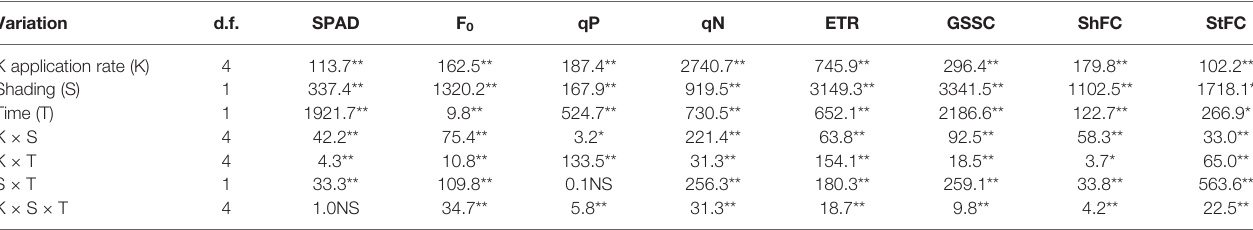
TABLE 2 | F -values from three-way repeated measures ANOVA on the effects of potassium rate (K0, K50, K100, K150, and K250), shading treatment (no shading, shading 10 days after anthesis) and different sampled time (10 and 15 days after anthesis) on leaf SPAD, chlorophyll fl uorescence parameters, grain soluble sugar content, sheath and stem fructan